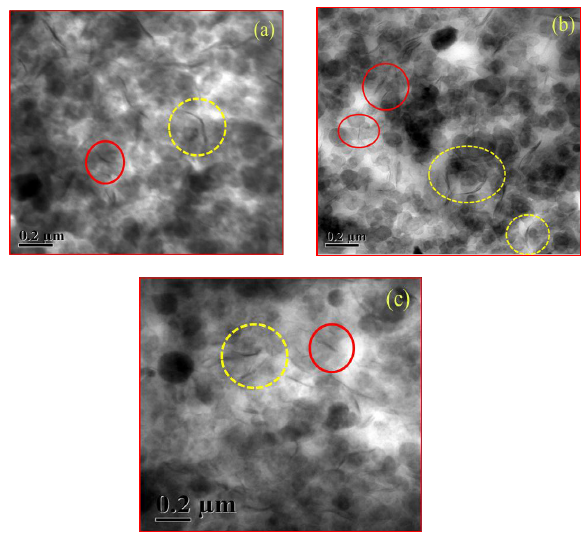
Figure 2: TEM Photomicrographs confirms development of